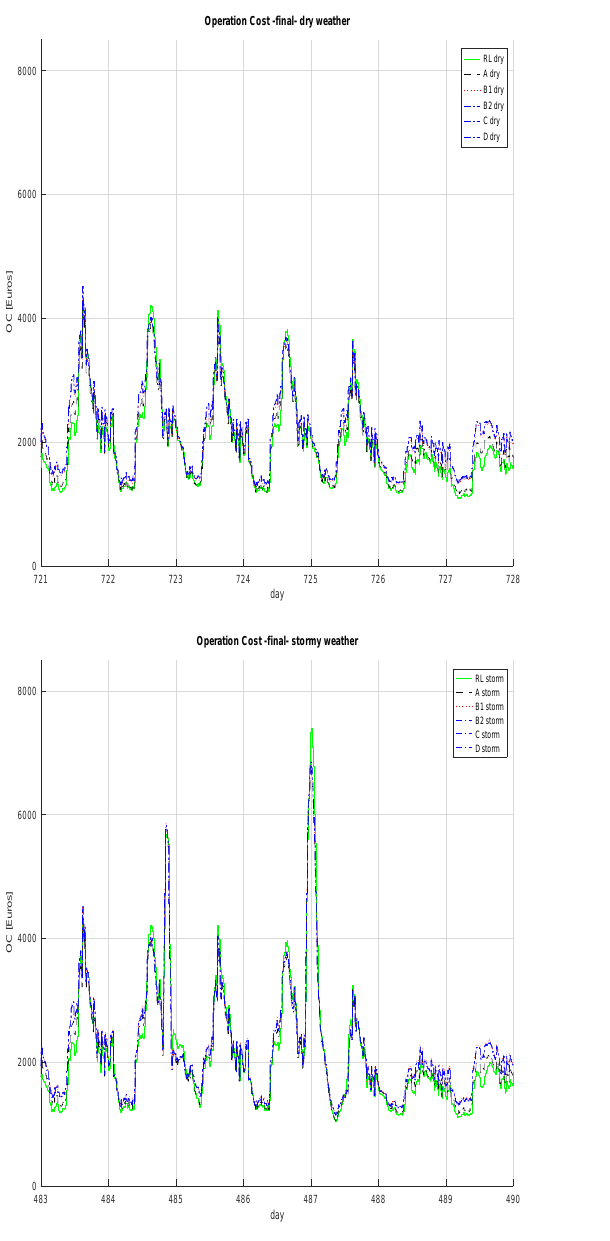
Figure 14. Operation Cost OC for the final